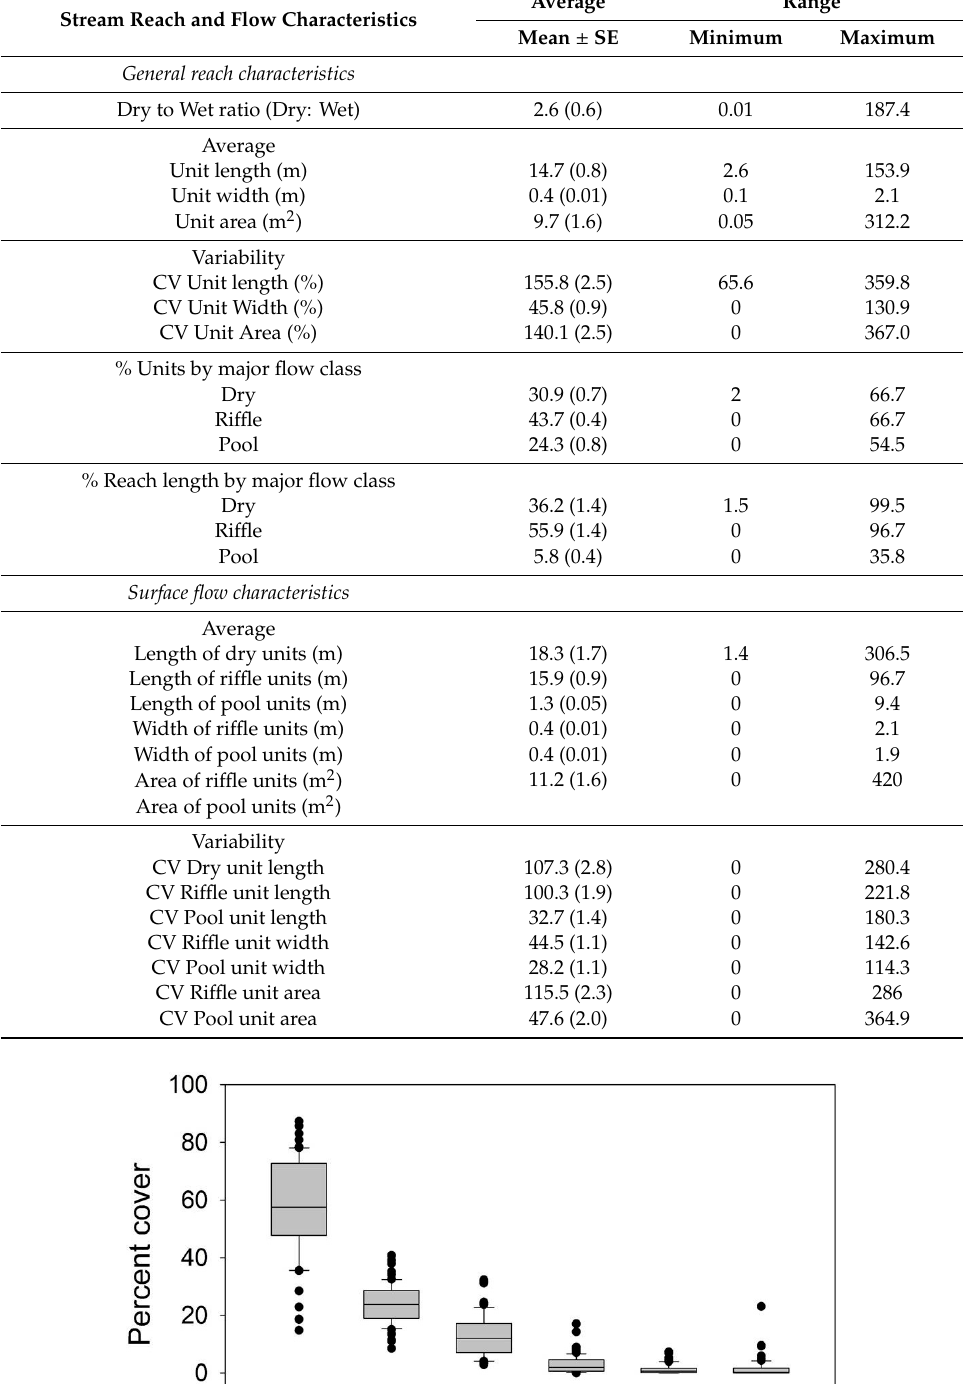
Table 2. Headwater stream reach and reach surface flow characteristics examined for 65 stream reaches sampled repeatedly from 1996–2011 in Western Oregon, USA. Average (standard error), minimum and maximum values are shown.